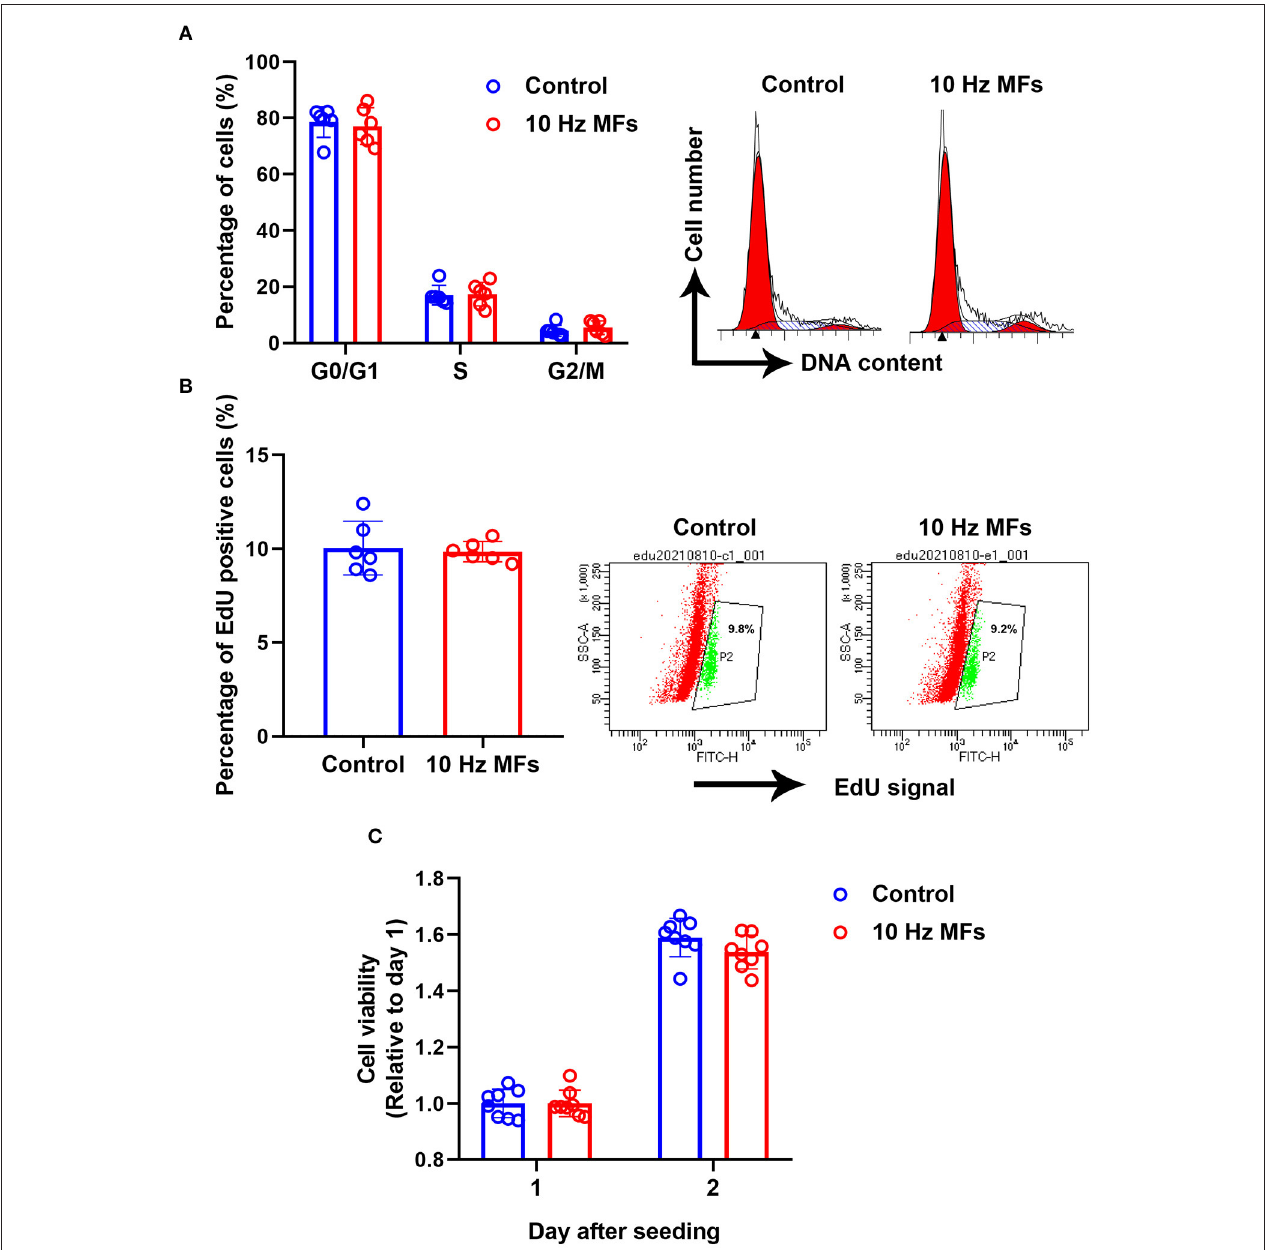
FIGURE 4 | The effect of 10Hz pulsed MFs exposure on cell cycle progression and proliferation. (A) Cell cycle distributions were determined by PI staining, (B) cell proliferation was determined by EdU assay, and (C) cell viability was determined by CCK8 assay of 2BS cells in control and 10Hz pulsed MFs exposure group. Data were presented as mean ± SD. MFs, magnetic